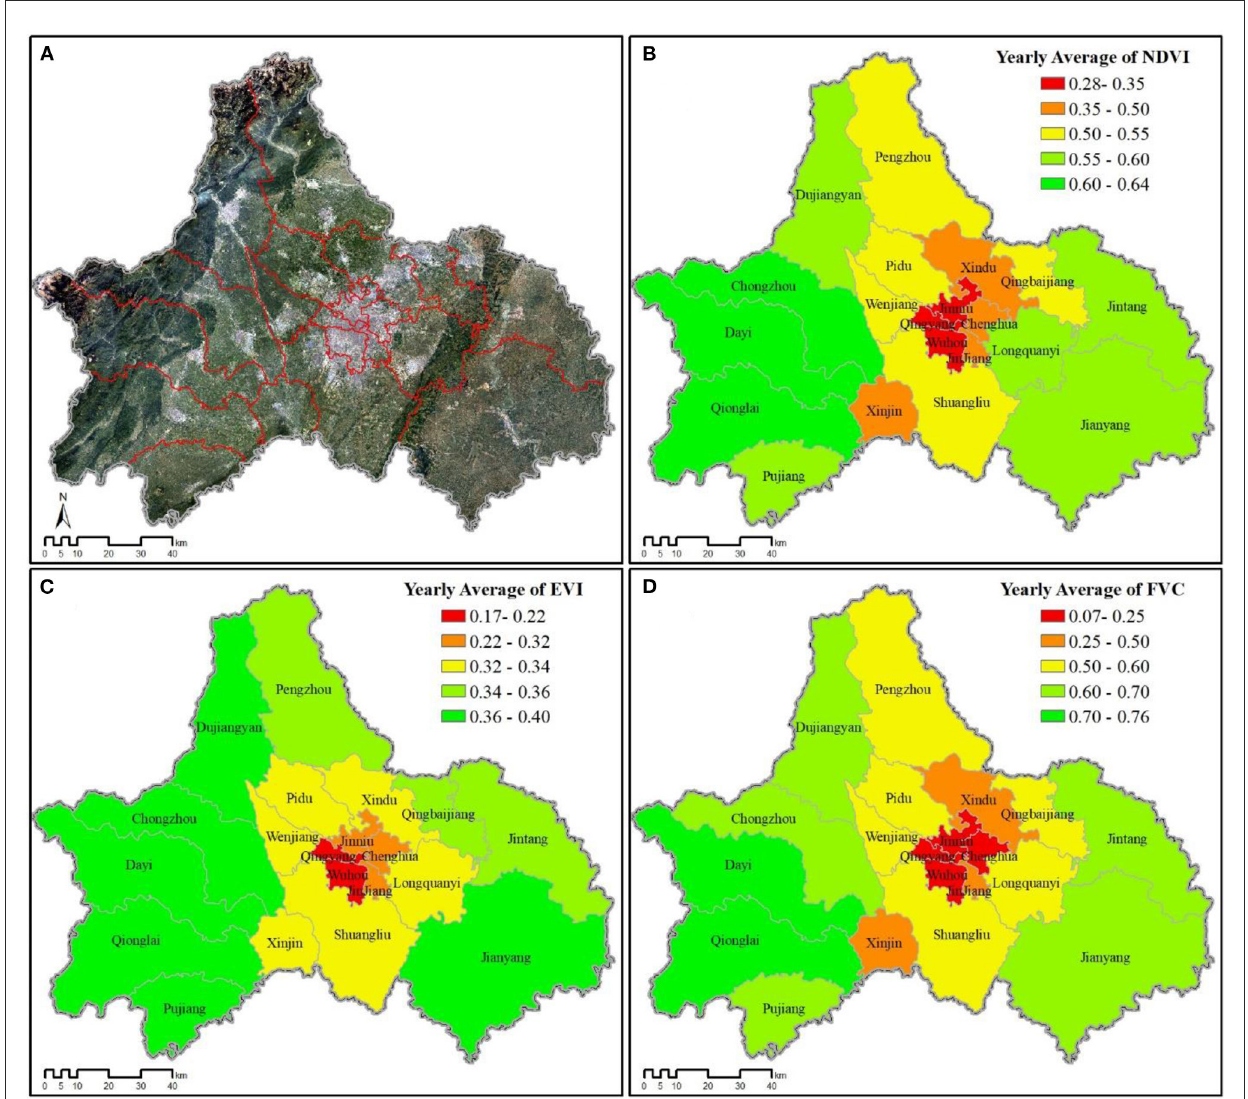
FIGURE3 Greenspace variability for all county-level jurisdictions across Chengdu (2016). (A) Satellite image of Chengdu. (B) Yearly NDVI average. (C) Yearly EVI average. (D) Yearly FVC average.